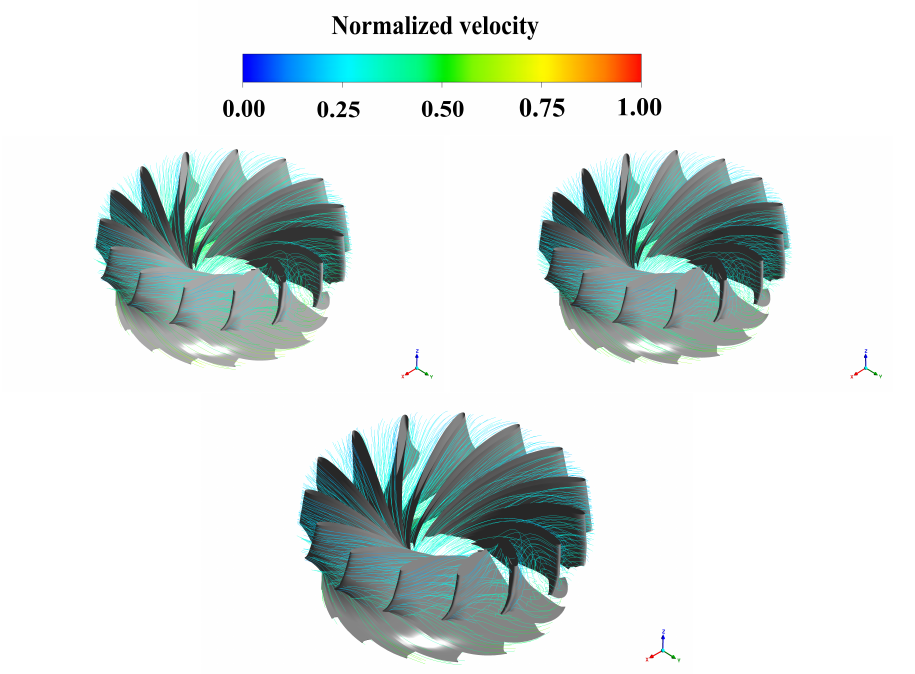
Figure 12. Velocity distributions of the runner of the 0.5 mm ( top-left ), 1.5 mm ( top-right ), 2.5 mm ( lower ) radial installation deviation